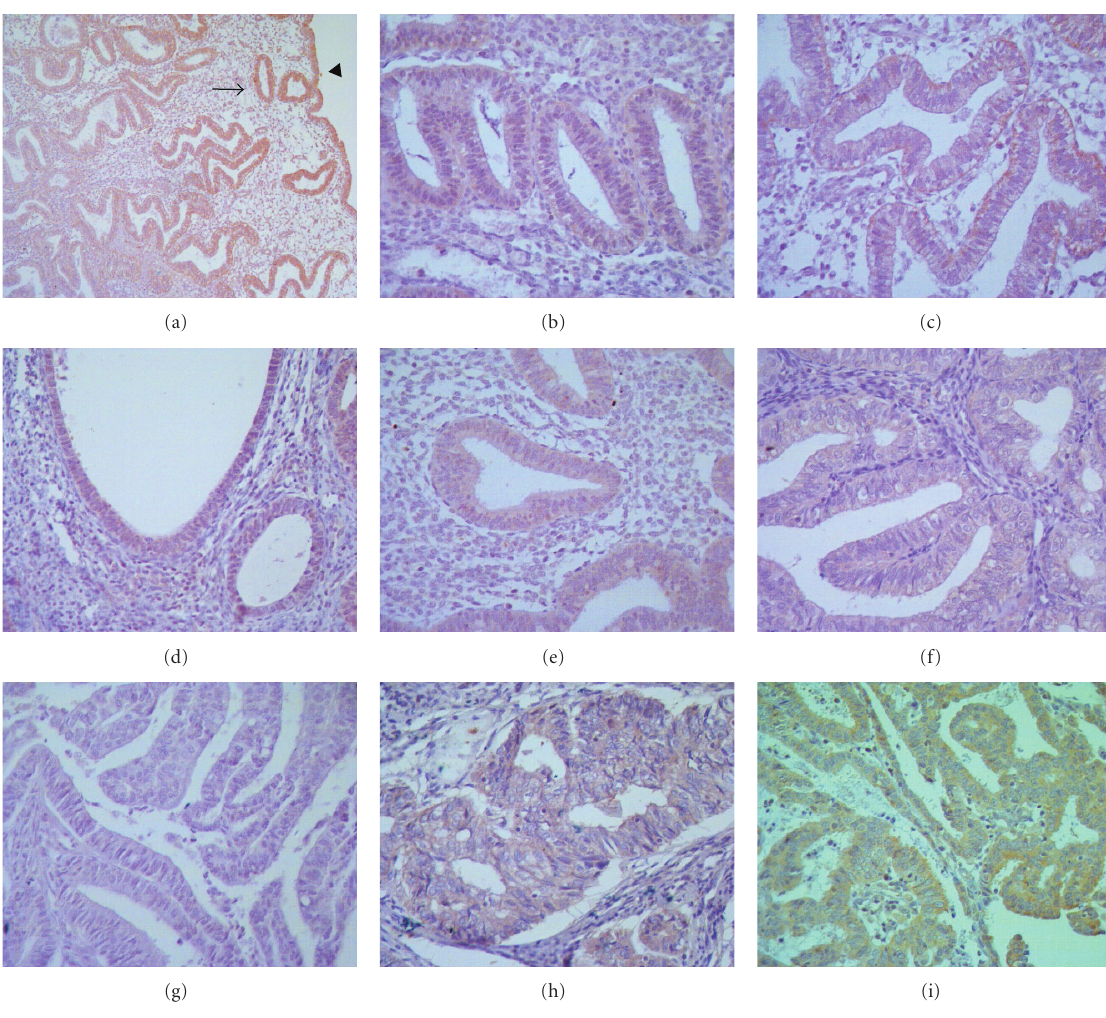
Figure 1: Wnt7a protein expression in endometrial tissues. (a) Wnt7a staining in the glandular epithelial cells (arrow) and in the luminal epithelial cells (triangle) ( × 100); (b) proliferative endometrium ( × 400); (c) secretory endometrium ( × 400); (d) atrophic endometrium ( × 400); (e) simple hyperplasia ( × 400); (f) complex hyperplasia ( × 400); (g) endometrial carcinoma with no Wnt7a staining ( × 400); (h) endometrial carcinoma with moderate Wnt7a staining ( × 400); (i) endometrial carcinoma with strong Wnt7a staining ( ×